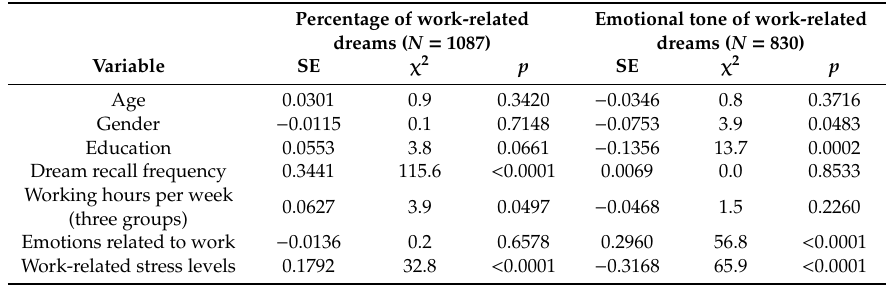
Table 5. Ordinal regression analysis for the categorized (ordinal) percentage of work-related dreams (retrospective estimates) and the overall emotional tone of work-related dreams (only for individuals currently working).